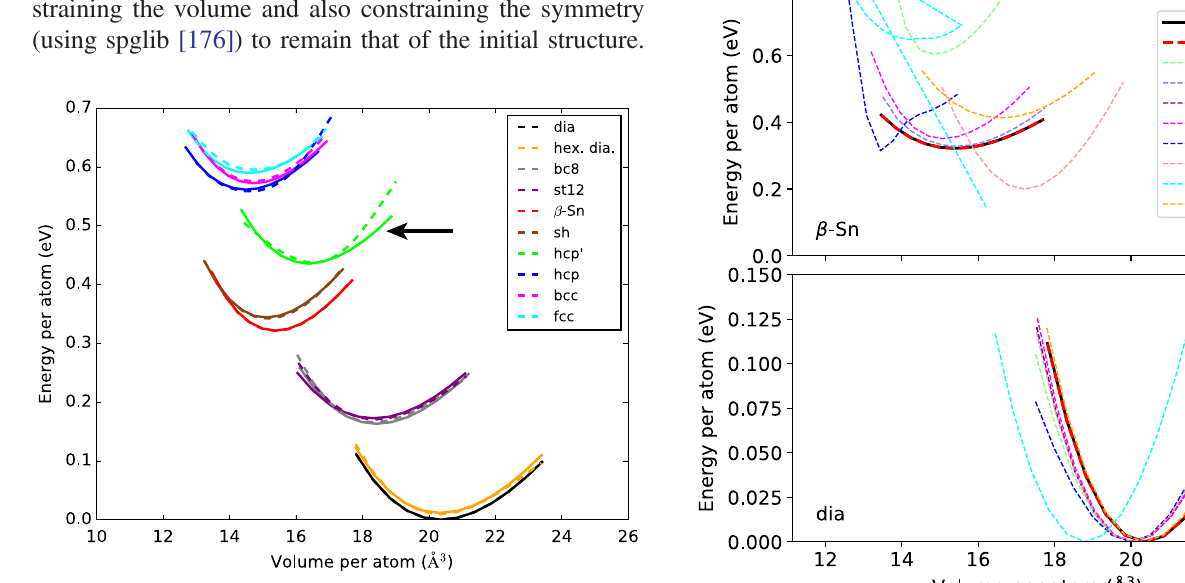
FIG. 6. Energy per atom relative to diamond structure vs volume per atom for fcc (top), β -Sn (middle), and diamond structure (bottom), computed with the DFT (black, solid line), GAP (red dashed line), and all other models (various colors, dashed lines). Note different y -axis ranges in each